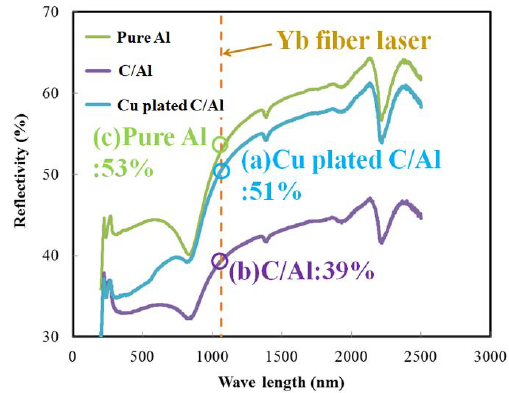
Figure 12. Light reflectivity of ( a ) Cu plated C/Al mixed powder, ( b ) C/Al mixed powder, and ( c ) pure aluminum powder, measured using a spectrophotometer.